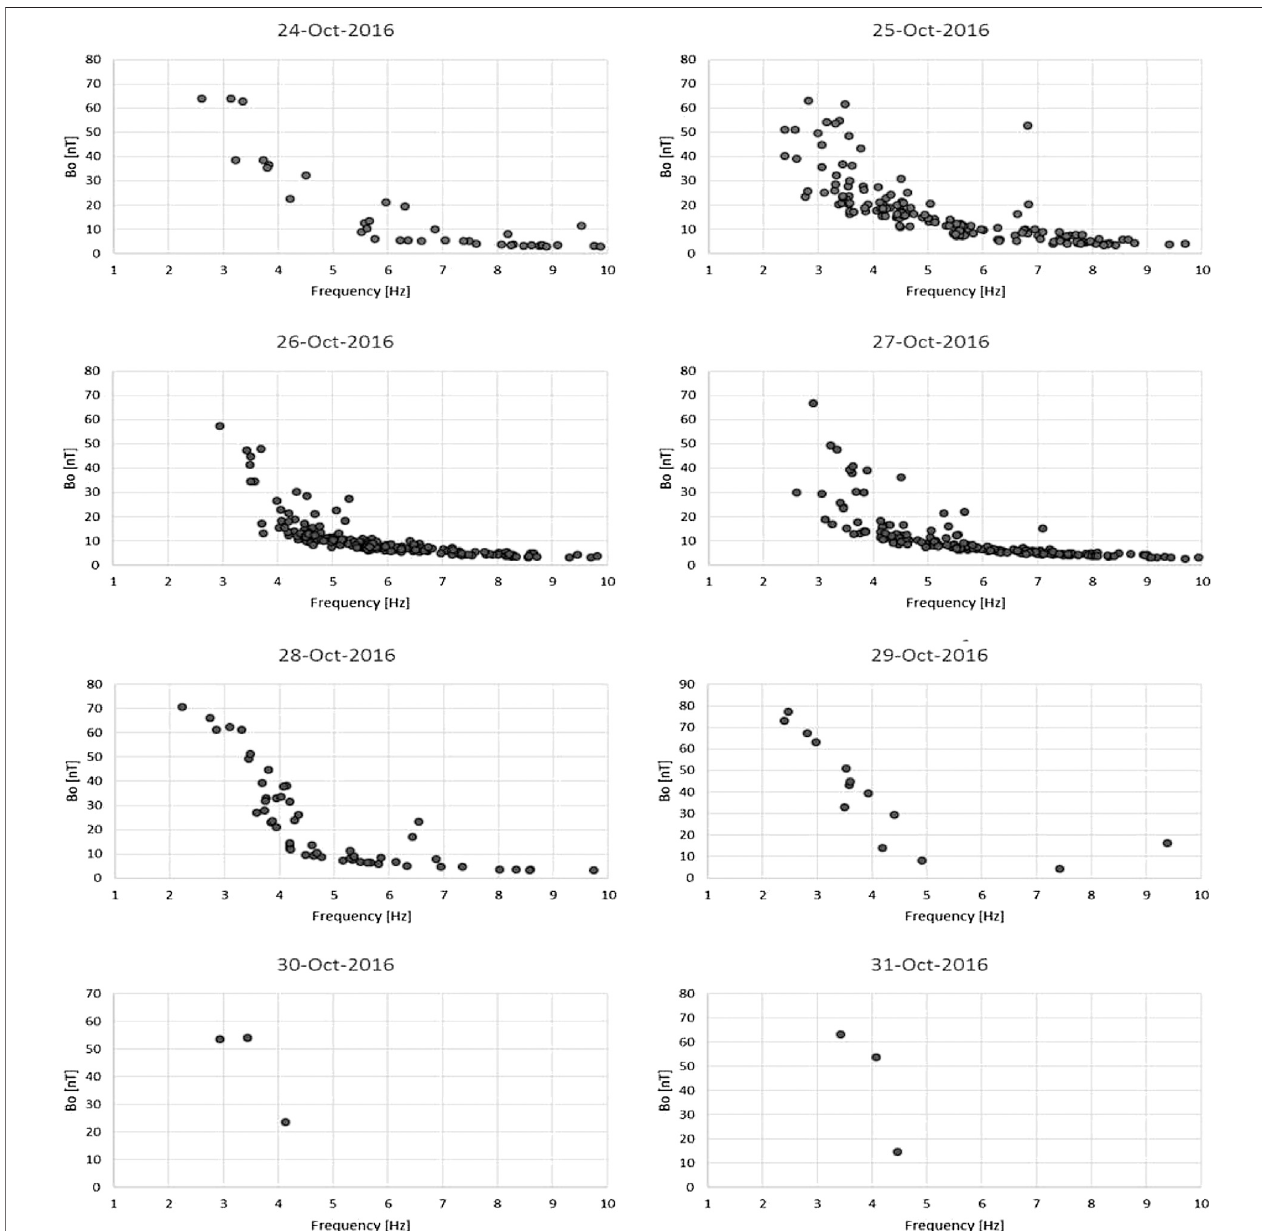
FIGURE 7 | The daily spectrum from 24 to October 31, 2016. From 24 October, the detector recorded an increase in the number of pulses below 10 Hz. The detector recorded some pulses with amplitudes near 80 nT between 2 and 3 Hz even though the gain of the preampli fi er was lower at those frequencies. It is evident from the above graphs that the magnetic induction threshold is frequency dependent after that the limit of 110 mV was fi xed.